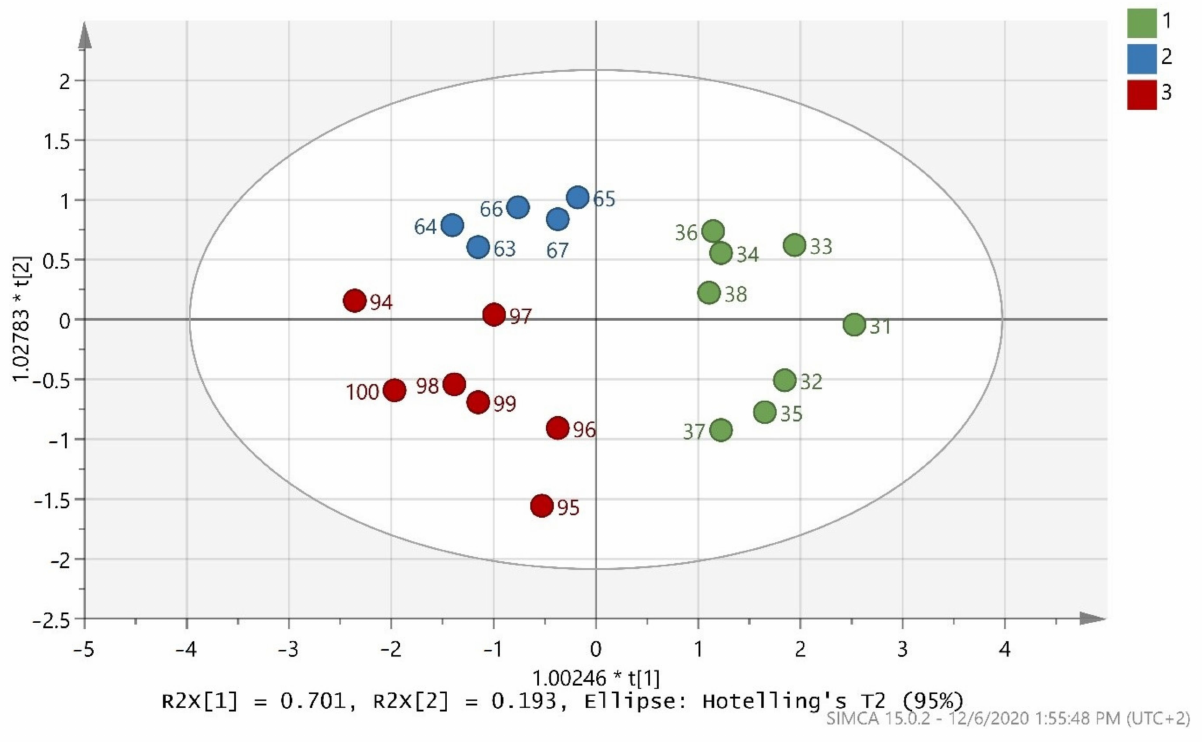
Figure 2. Score scatter plot (t2/t1) from OPLS-DA modeling of the test set where 1 = Maurolia (Messinia), 2 = Lianolia Kerkyras (Preveza), and 3 = Koroneiki (Preveza). A = 2 + 0 + 0 components, R 2 X(cum) = 0.894, R 2 Y(cum) = 0.706, and Q 2 (cum) = 0.641 and 1.00246 * t[1] means 1.00246 × t[1] as well as 1.02783 * t[2] means 1.02783 ×